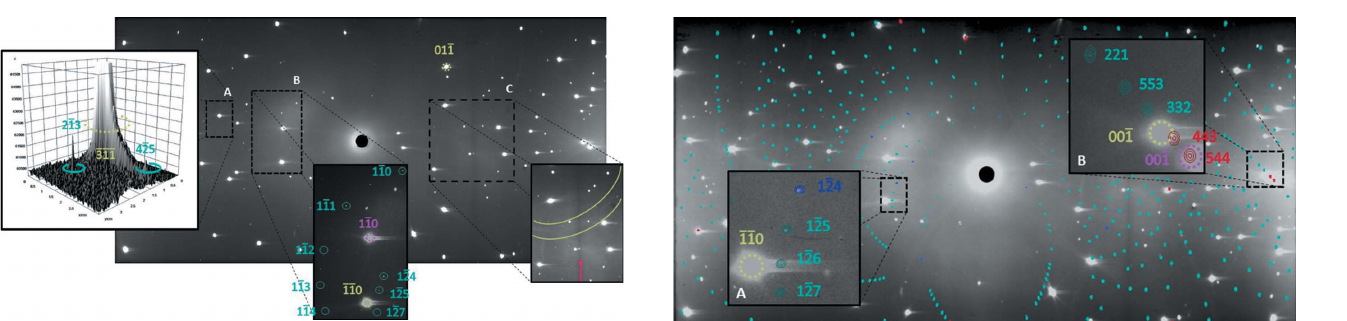
Figure 3 Laue diffraction pattern of copper sulfate pentahydrate recorded at 0.71 GPa, ’ = (cid:8) 30 (cid:6) , using the mini-DAC. The pattern is dominated by scattering from the two diamond anvils. Inset A shows a surface plot of the reflection of one anvil (green) and its elongated tail due to residual fluorescence in the detector, the intensity being extremely high compared with that of the 213 and 425 sample reflections (light-blue). Inset B shows eight reflections coming from the sample, reflection 110 of one anvil (green) and reflection 110 of the other anvil (purple). The contrast was adjusted in the insets for the sake of clarity. Inset C represents the pseudo-Kossel line centred on the 011 reflection (green) and a vertical shadow cast by the gasket (magenta).